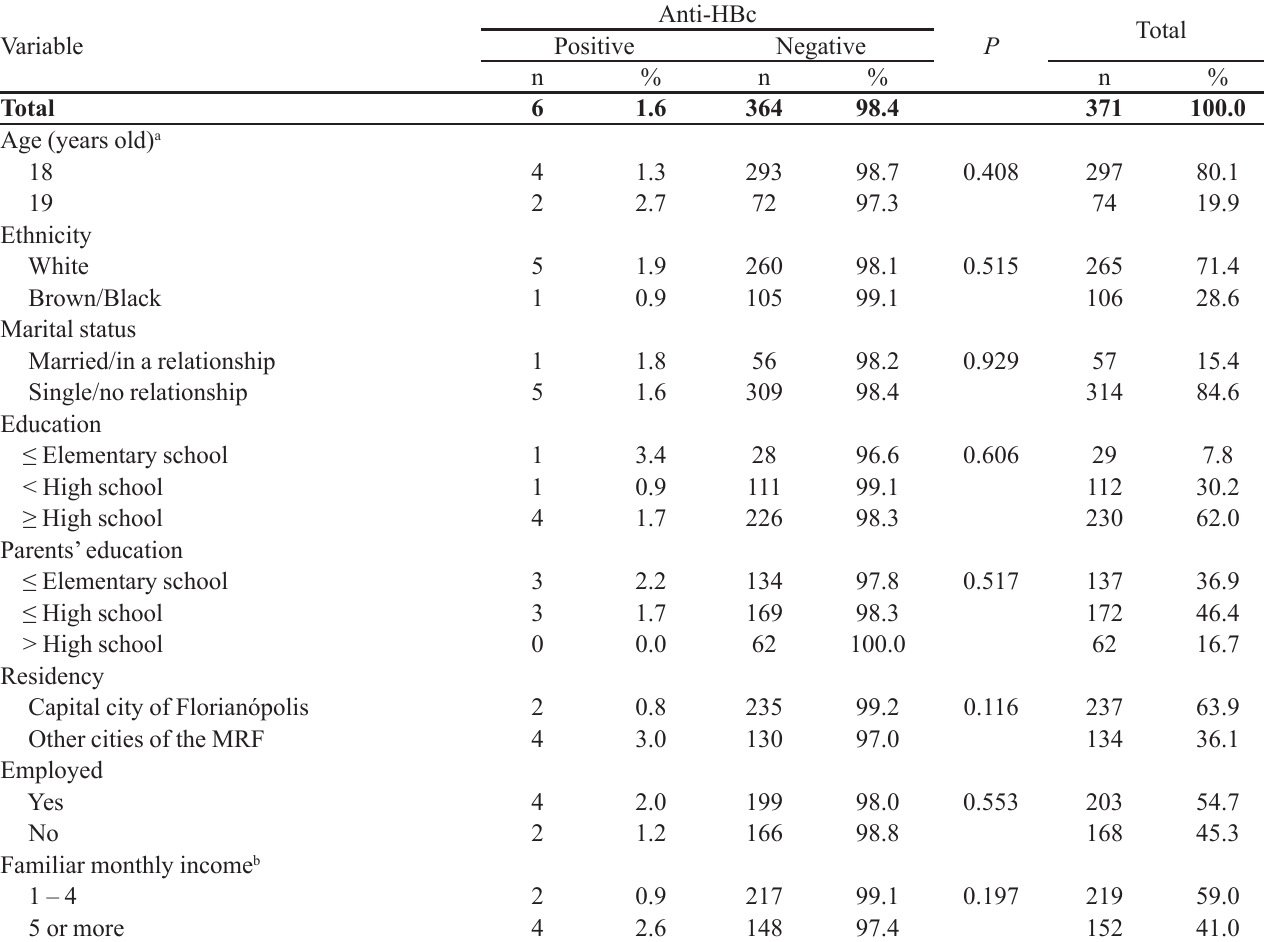
TABLE I - Demographic and socio-economic characteristics of young adults in South Brazil by anti-HBc status